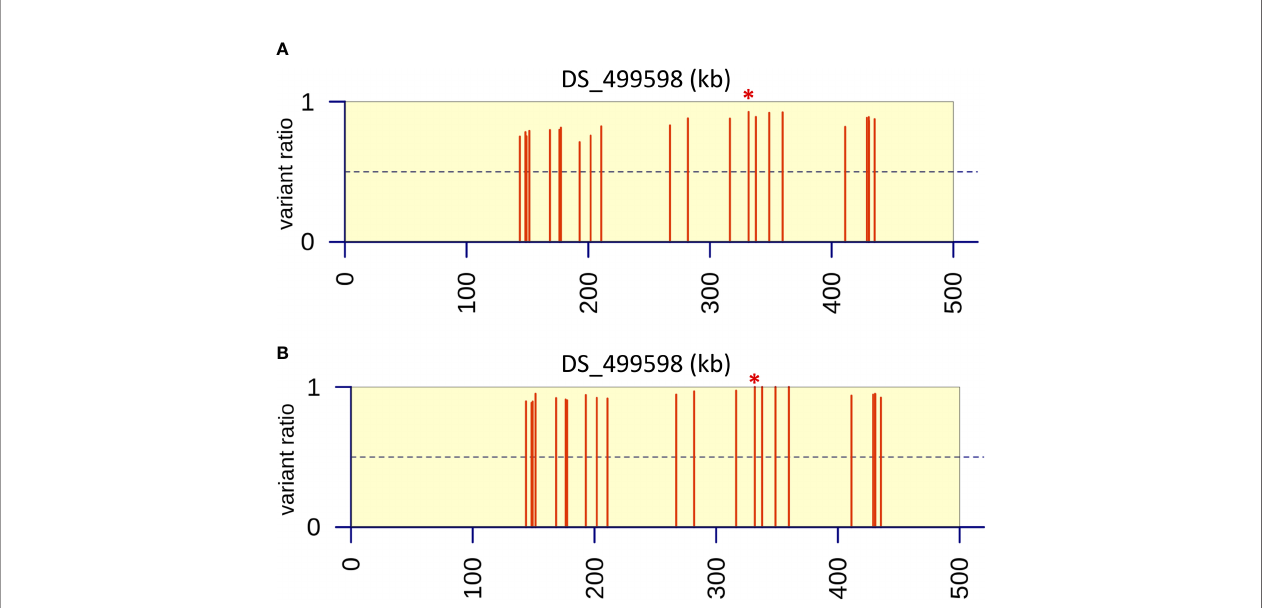
FIGURE 5 | Variant ratio plots to show extent of heterozygosity or homozygosity at SNPs identi fi ed on contig DS_499598 from bioinformatic analysis. (A) Data analysis of resistant parent and progeny pool (n=40) derived after six back crosses (BC6). (B) Data analysis of resistant parent and progeny pool (n=80) derived after two back crosses (BC2). Values were calculated as the ratio of the average coverage supporting that variant compared to the average total coverage at that given position across the three replicates in the progeny pools. The red asterisk indicates the position of the M220K causal variant in cyp51A